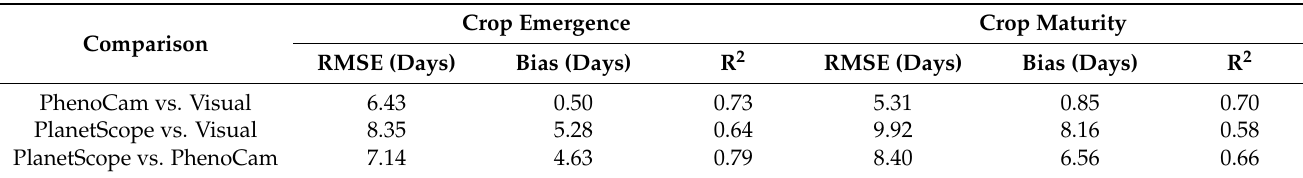
Table 4. The accuracy statistics of comparisons among PlanetScope, PhenoCam, and visual phenology with all the shared site-year observations using the CUR-based Greenup for crop emergence and DER-based EOS for crop